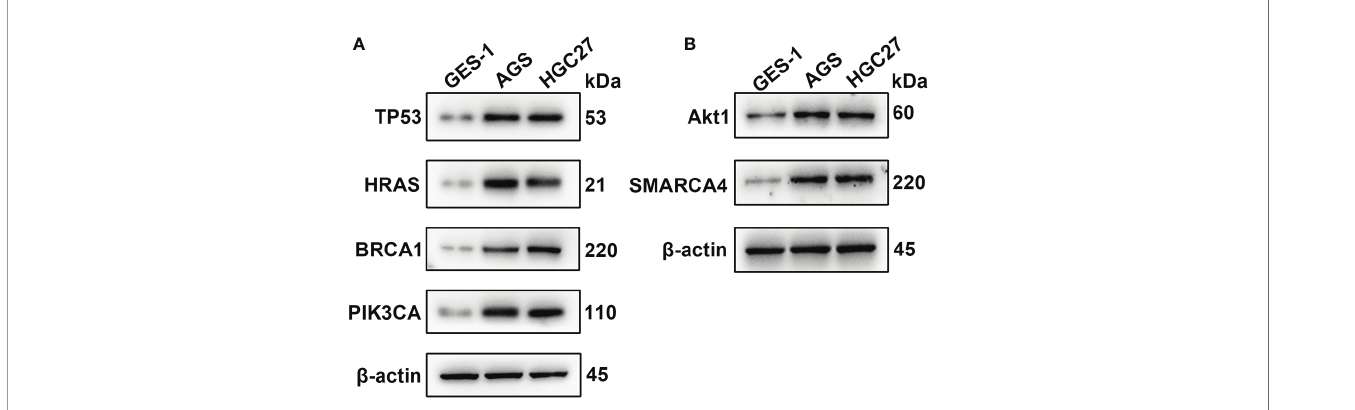
FIGURE 11 | Western blotting analysis of the key genes; b -actin was used as a loading control. (A) Protein expression of TP53, HRAS, BRCA1 and PIK3CA. (B) Protein expression of AKT1